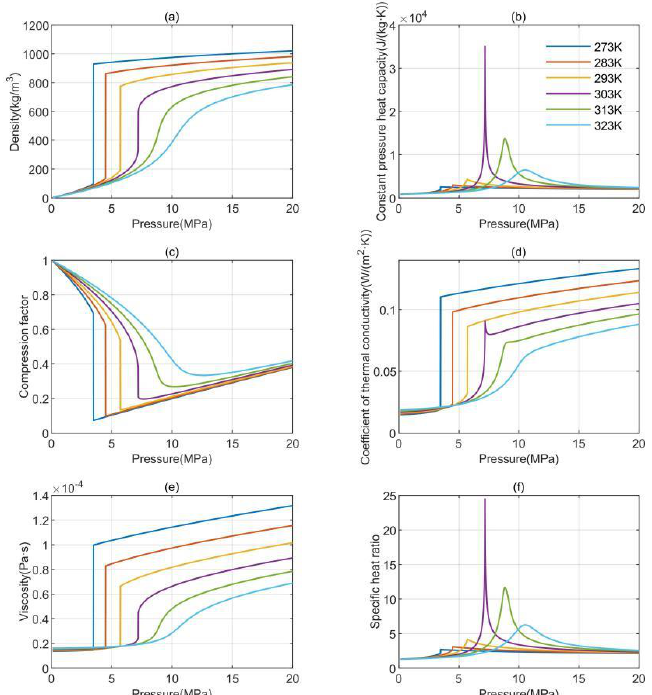
Figure 8. Thermophysical properties of carbon dioxide curves at temperatures ranging from 273 to 373 K (six different temperatures) and pressures ranging from 5 to 20 MPa: ( a ) density, kg/m 3 ; ( b ) isobaric heat capacity, J/(kg·K); ( c ) compressibility factor (Z); ( d ) thermal conductivity, W/(m·K); ( e ) viscosity, Pa·s; ( f ) specific heat capacity,